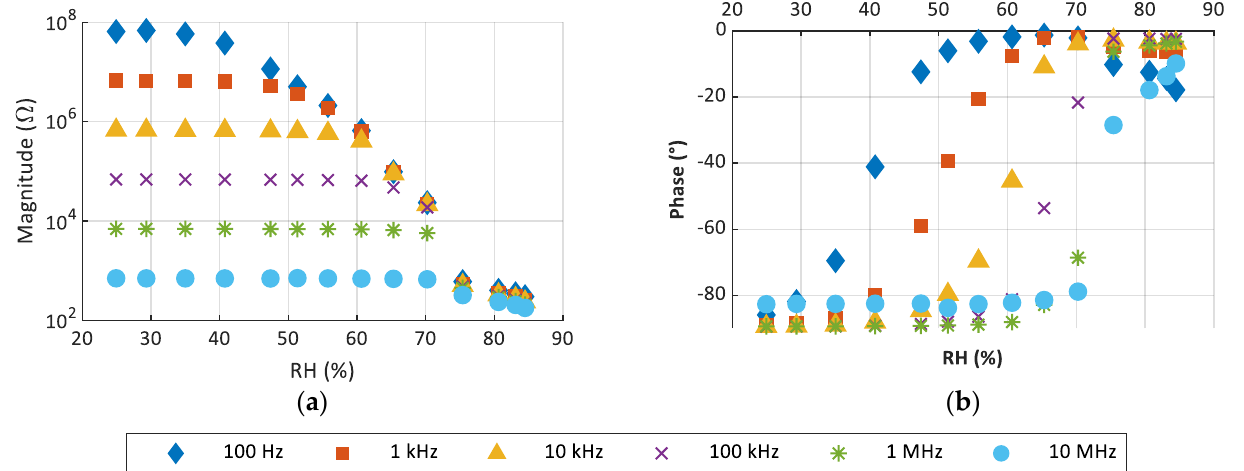
Figure 9. Impedance response towards RH at 40 °C. ( a ) Magnitude and ( b ) phase for Na-Pery drop-casted.